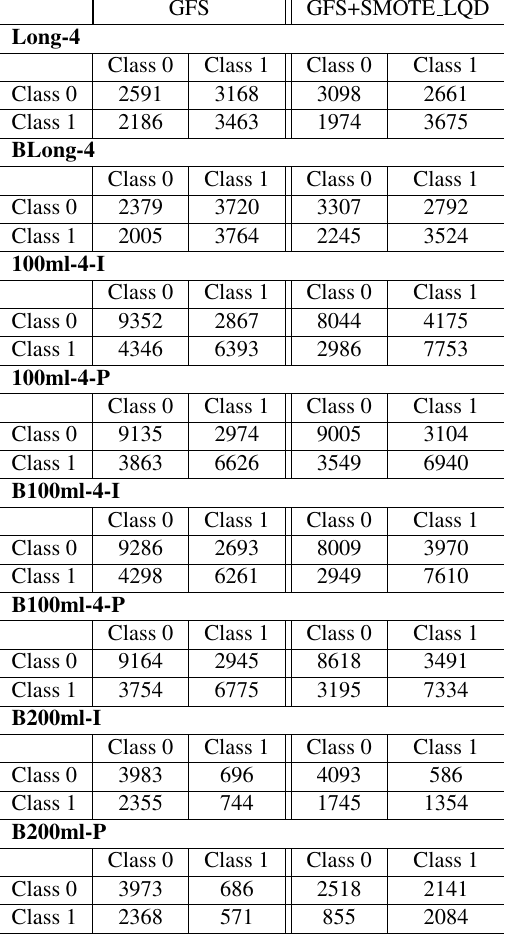
Table 5: Confusion matrix obtained in the low quality dasates of Athletics with unprocessed and preprocessed data (SMOTE